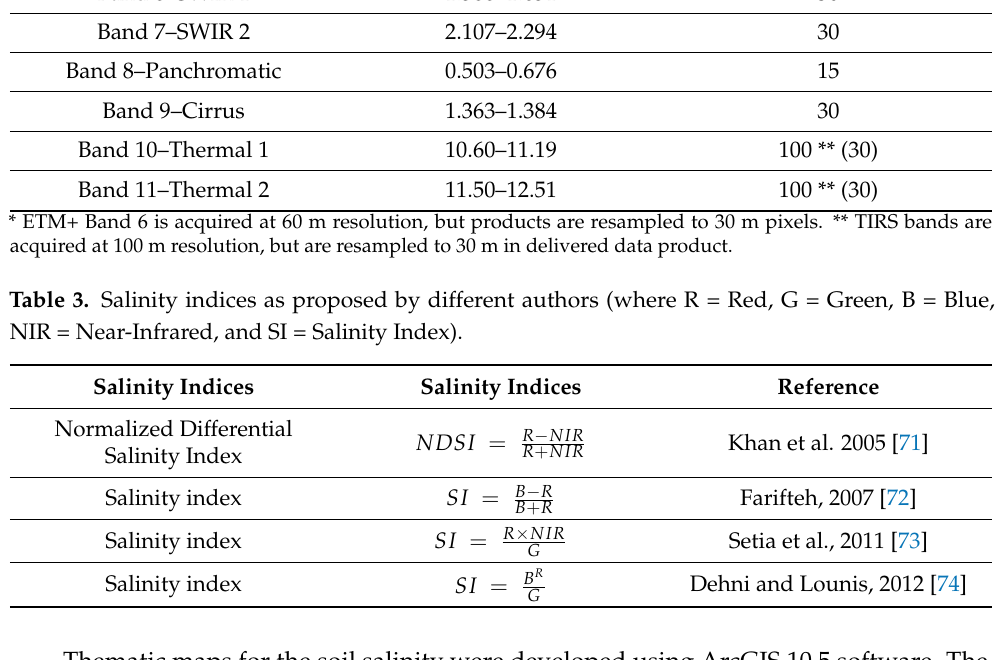
Thematic maps for the soil salinity were developed using ArcGIS 10.5 software. The- matic maps of the study area were generated using Inverse Distance Weighted (IDW) interpolation as recommended by AbdelRahman et al. [75] and Yao [76]. IDW interpolation determines cell values using a linearly weighted combination of a set of sample